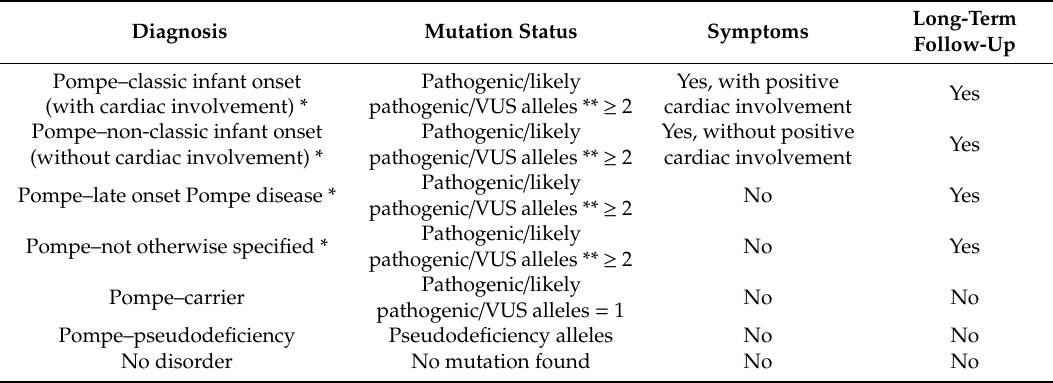
Table 1. California newborn screening Pompe disease diagnosis